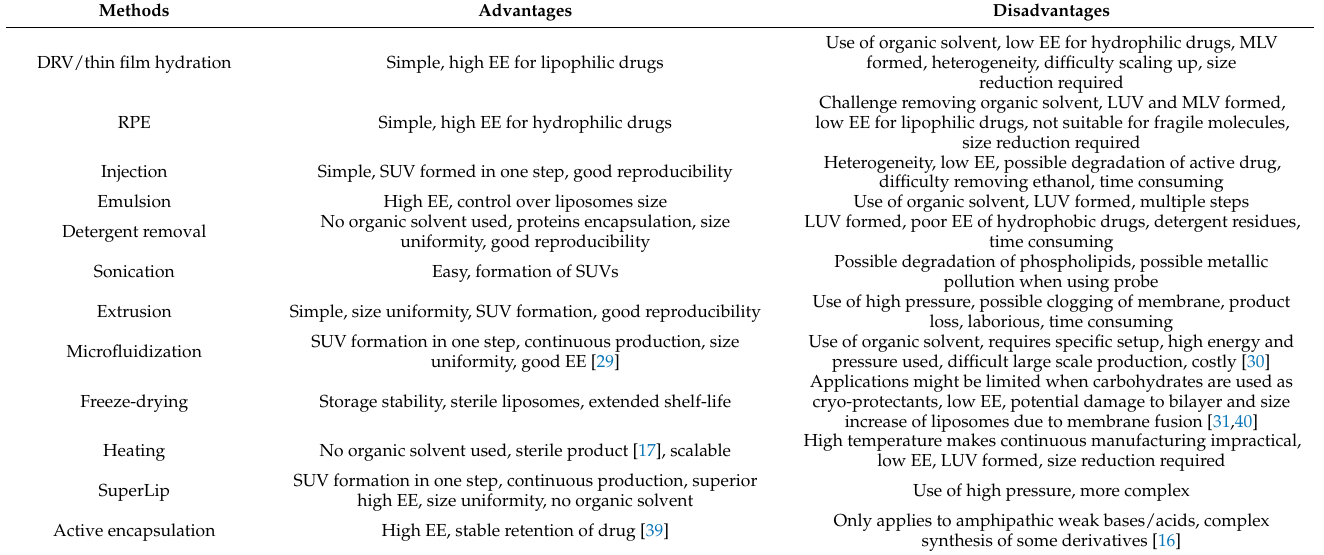
Table 1. Advantages and disadvantages of liposomes preparation